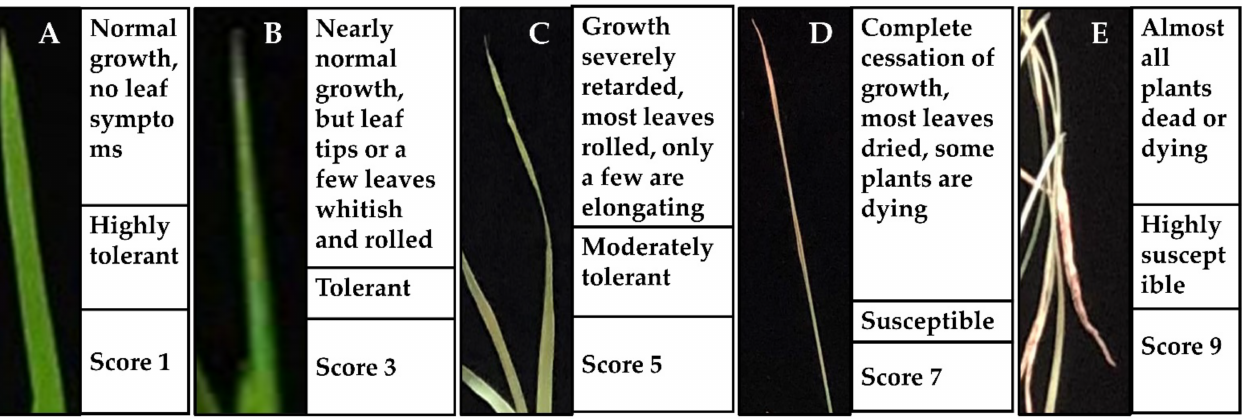
Figure 7. Standard evaluation system (SES) of the salinity response in rice leaves. ( A ) highly tolerant; ( B ) tolerant; ( C ) moderately tolerant; ( D ) susceptible; ( E ) highly